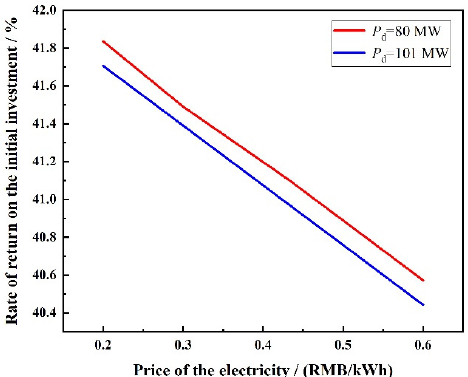
Figure 17. Rate of return on the initial investment vs. the price of the electricity.